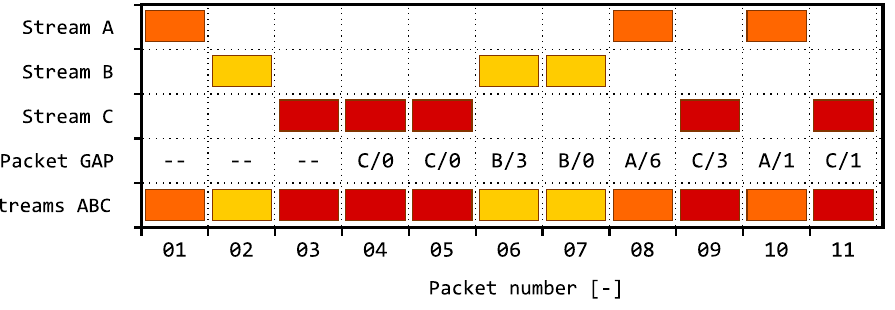
Figure 1. Example of using IPGA: analysis of absolute gap between two consecutive packets (letters indicate the packet origin, and numeric values stand for the number of intermediate packets).